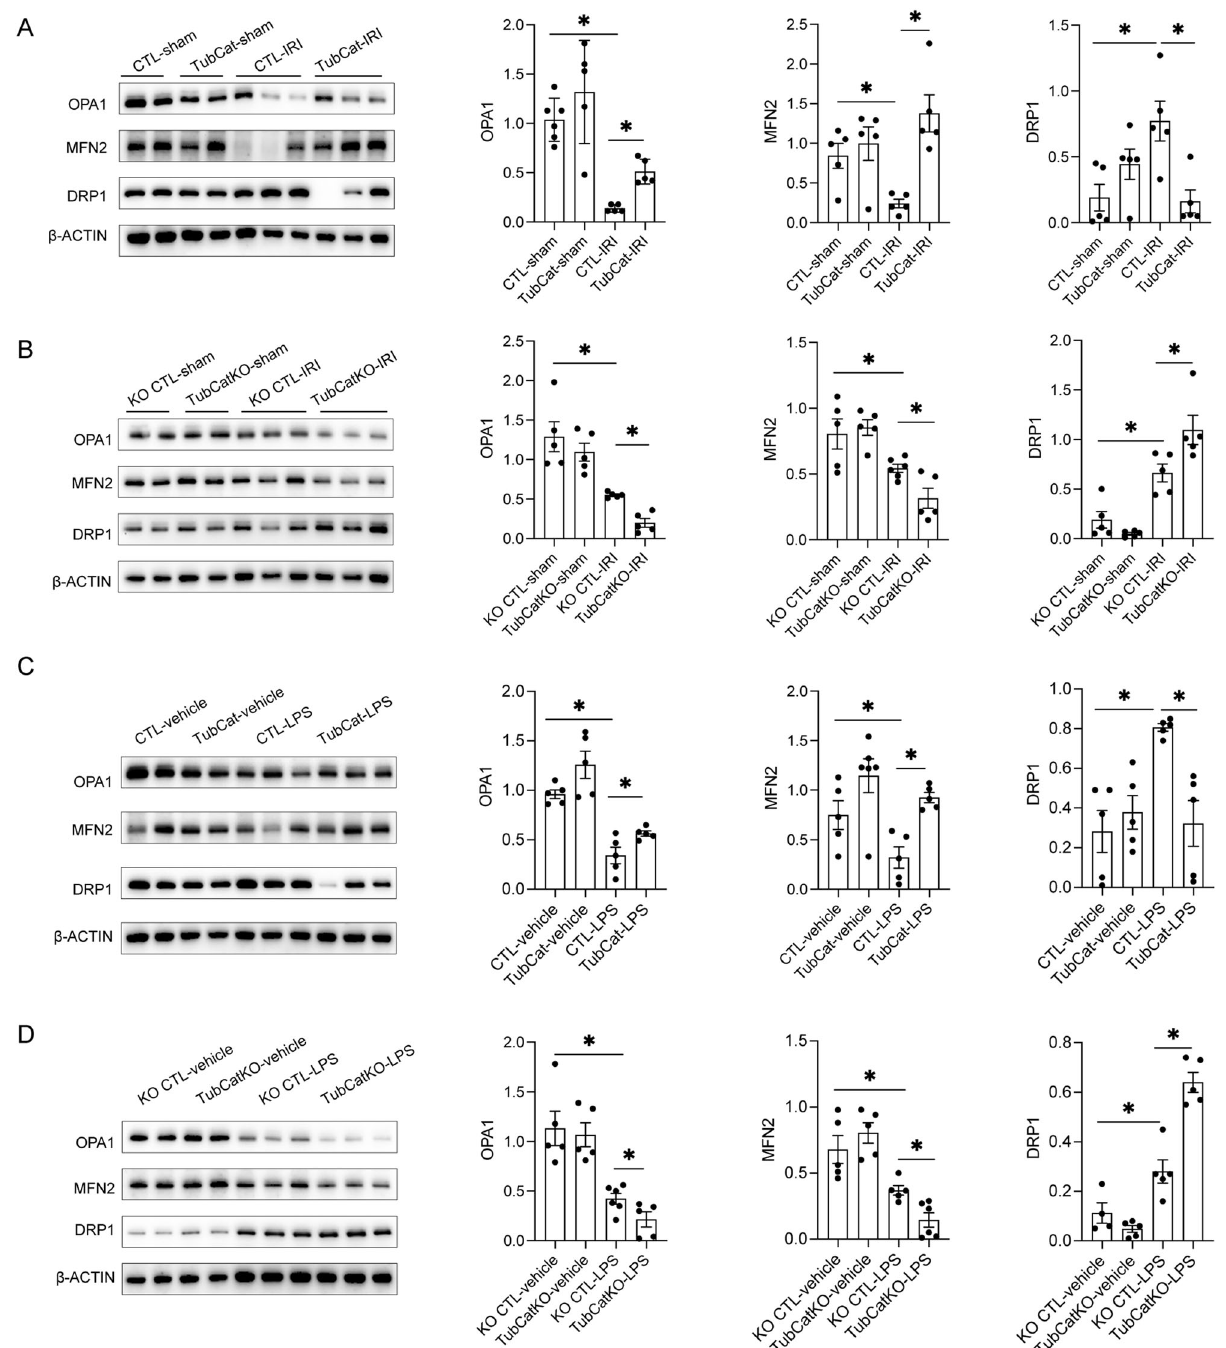
Fig. 7 β -catenin regulates tubular mitochondrial dynamics in IRI-induced- and LPS-induced AKI. A Representative western blots for mitochondrial fusion markers (OPA1, MFN2) and mitochondrial fi ssion protein DRP1 and their quantitation in TubCat-IRI mice. B Representative western blots for OPA1, MFN2, and DRP1 and their quanti fi cation in TubCatKO-IRI mice. C Representative western blots for mitochondrial fusion markers (OPA1, MFN2) and mitochondrial fi ssion protein DRP1 and their quantitation in TubCat-LPS mice. D Representative western blots for OPA1, MFN2, and DRP1 and their quantitation in TubCatKO-LPS mice. * p < 0.05; n = 5 in each group. decreased DRP1 expression. In agreement with these results, the alters mitochondrial homeostasis, leading to disturbance of reverse was found in tubular β -catenin knockout mice, which mitochondrial redox balance and mitochondria-dependent apop- con fi rmed a mitochondrial protective function of β -catenin tosis [13]. signaling. In addition, tubular β -catenin signaling regulates PGC- Our data shows that perturbation of mitochondrial dynamics in 1 α expression, which is reported to be decreased in various AKI AKI was partly corrected by β -catenin. Tubular stabilization of β -catenin promoted mitochondrial fusion and reduced mitochon- models (IRI, septic, folic acid, and cisplatin) [18, 24, 47, 48]. Enhancing PGC-1 α expression by pharmacological strategies drial fragmentation as indicated by increased MFN2, OPA1, and